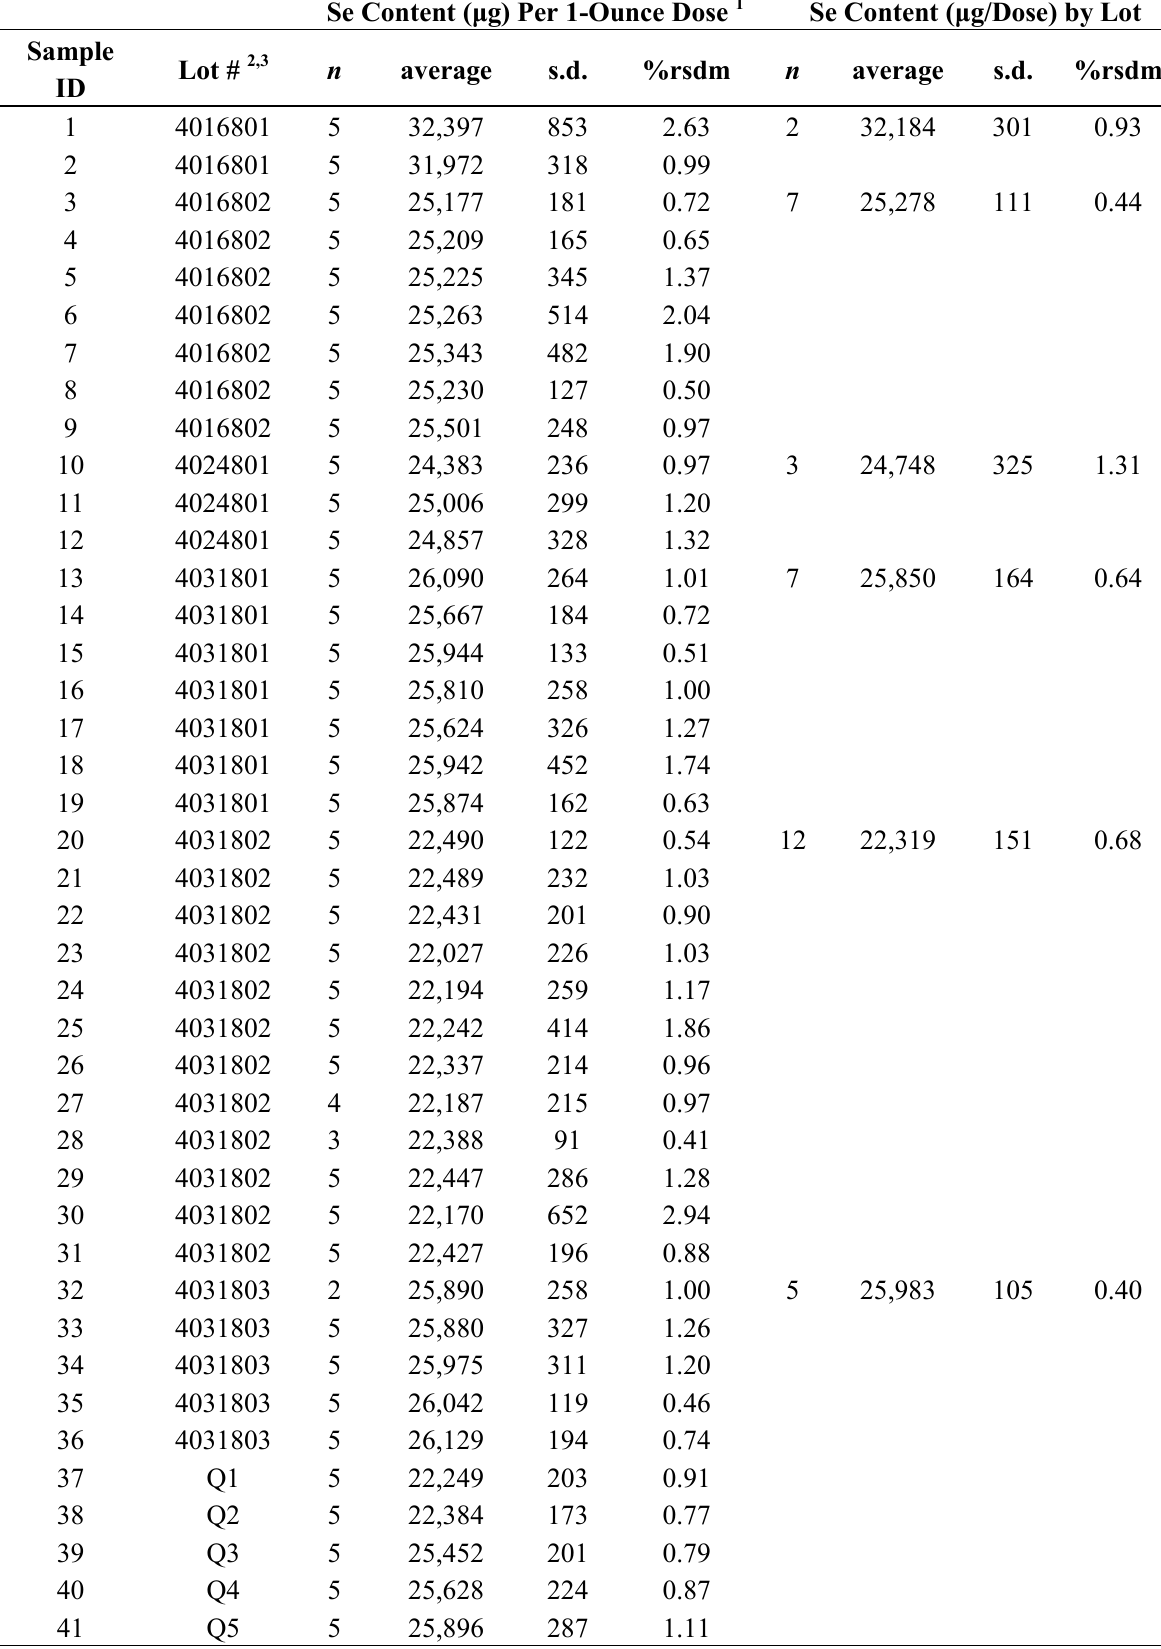
Table 2. Se content (μg) per 1-ounce recommended daily dose of Total Body Formula (TBF) dietary supplement products grouped by product lot